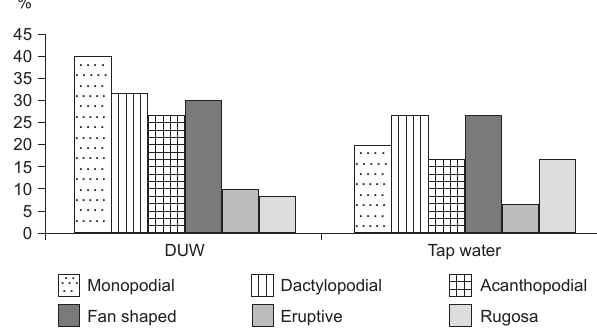
Fig. 1. – Frequency of FLA morphotypes in dental unit and tap